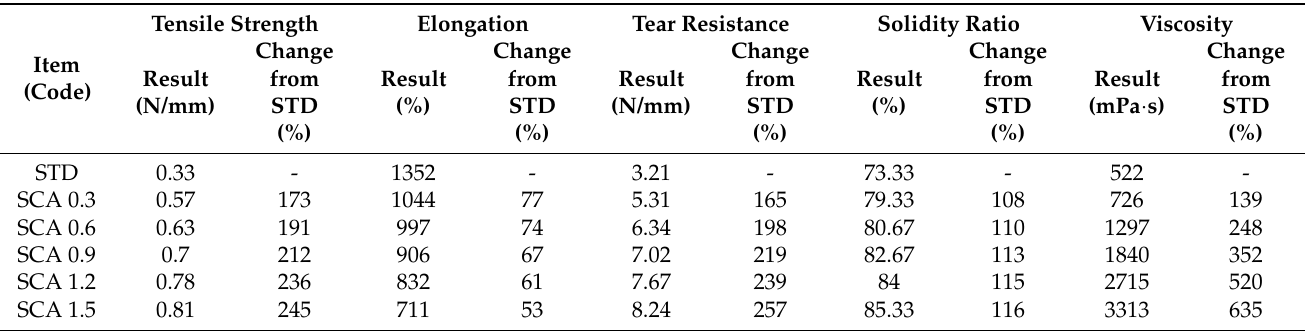
Table 7. Physical property results according to the amount of silane coupling agent added and increase/decrease rate compared to STD.